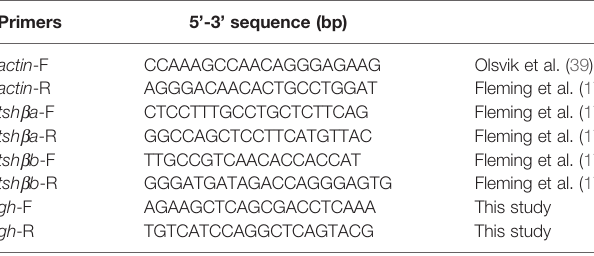
TABLE 1 | Primer sequences used in qPCR ampli fi